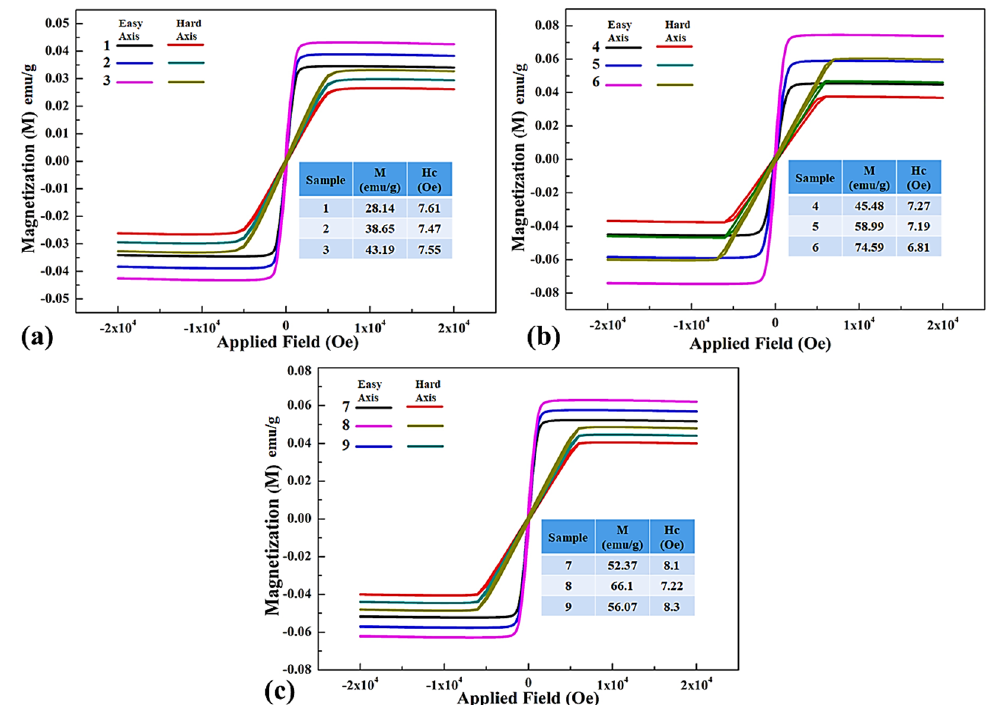
Figure 6. Room temperature magnetization measurements at 2.21 T ( a ) Ni 76 Fe 19 Ag 5 thin films prepared with Ar gas using different sputtering power; ( b ) Ni 72 Fe 18 Ag 10 thin films prepared with Ar gas using different sputtering power; and ( c ) Ni 72 Fe 18 Ag 10 thin films prepared with N 2 +Ar gas mixture using different nitrogen flow rate.